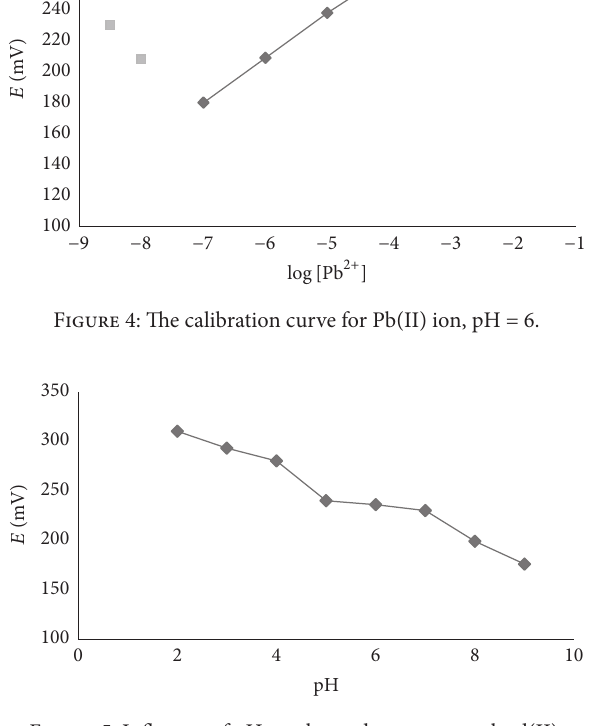
F 5: In�uence of pH on electrode response to lead(II). T 2: Matched potential selectivity coefficient for interfering